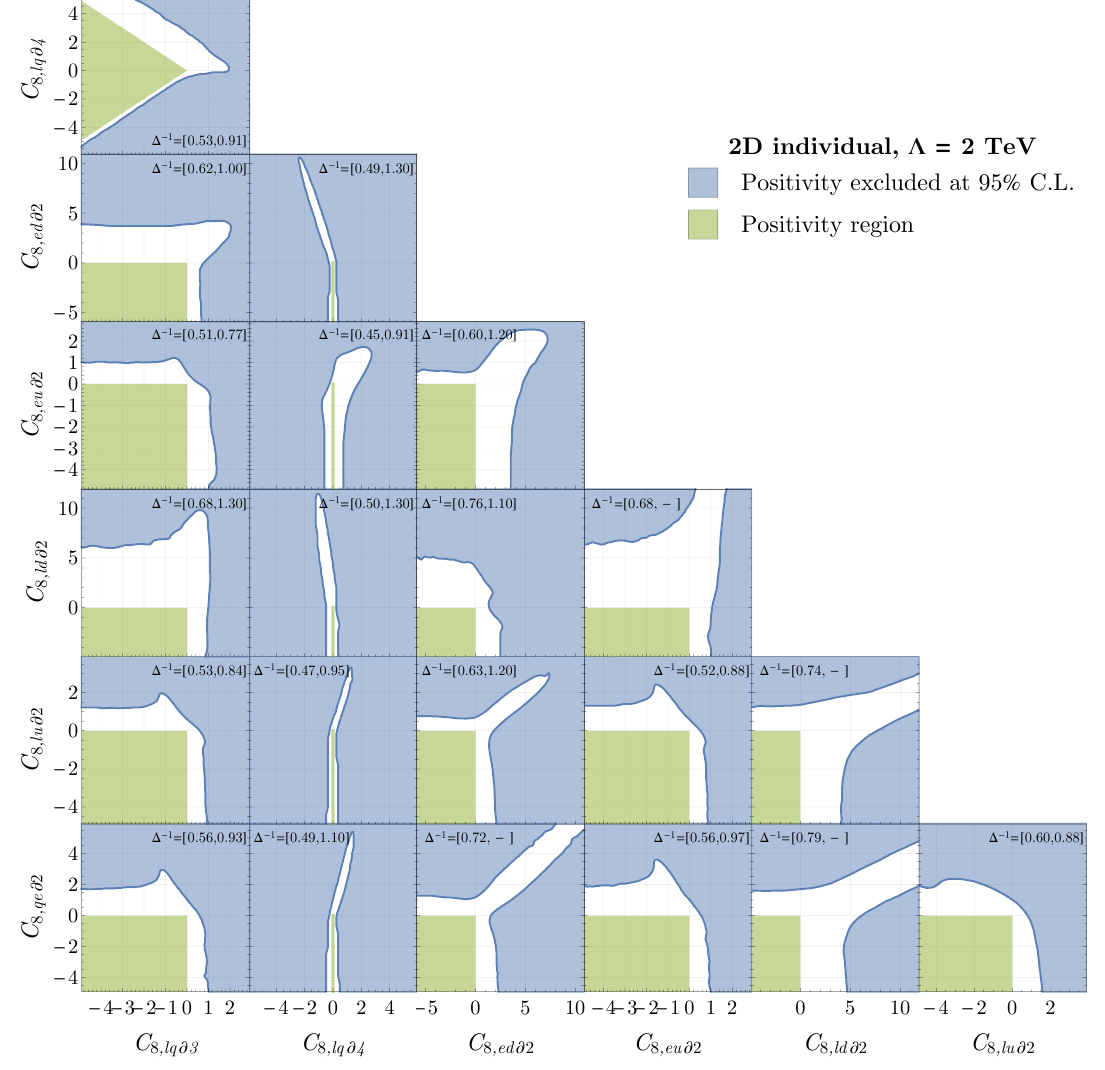
Figure 6 . Sensitivity to positivity violation using the double-differential distributions of the B 0 and D 0 angular moments. The elastic positivity bounds of table 1 are shaded in green. Blue shaded areas correspond to parameter points outside the allowed region that can be excluded at the 95 % C.L. . We set Λ = 2 TeV in this